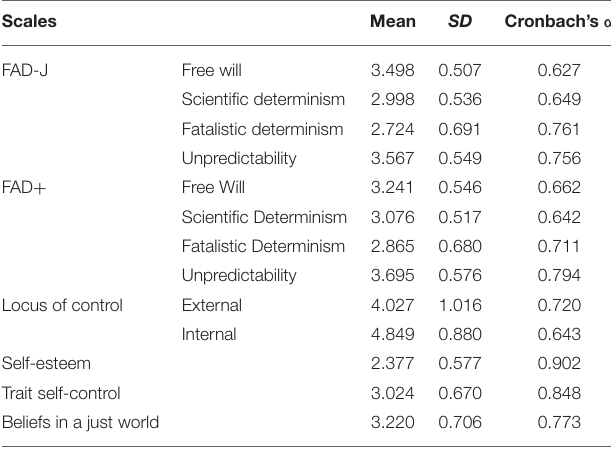
TABLE 5 | Mean, SD, and Cronbach’s alpha of all scales.